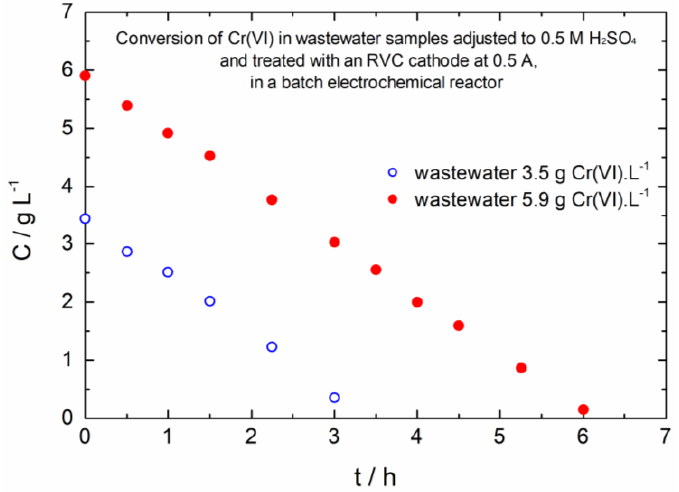
Figure 8. Concentration of Cr(VI) vs. time (h) plots during the electrolysis of 350 mL wastewater samples in a batch reactor, using a reticulated vitreous carbon (RVC) cathode electrode and a constant current of 0.5 A.